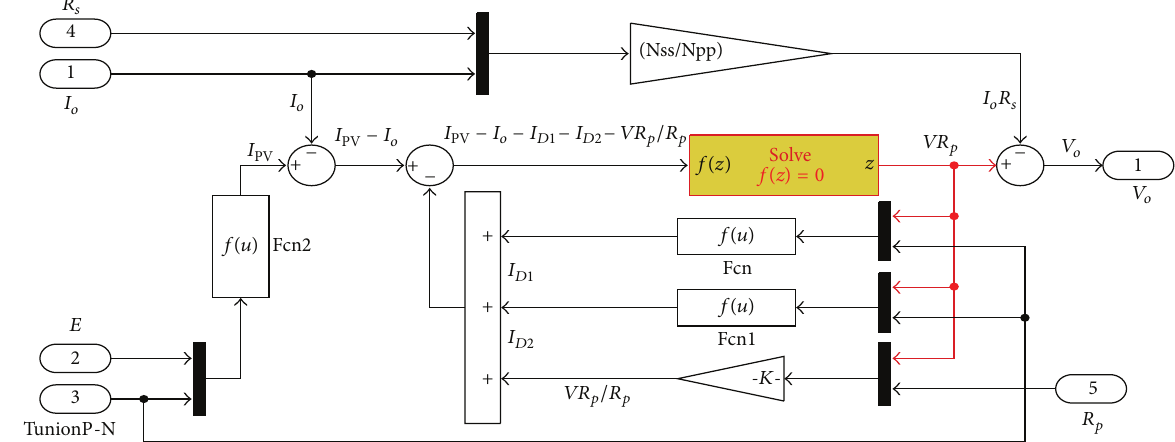
Figure 8: Cell mathematical model inside of MATLAB Simulink